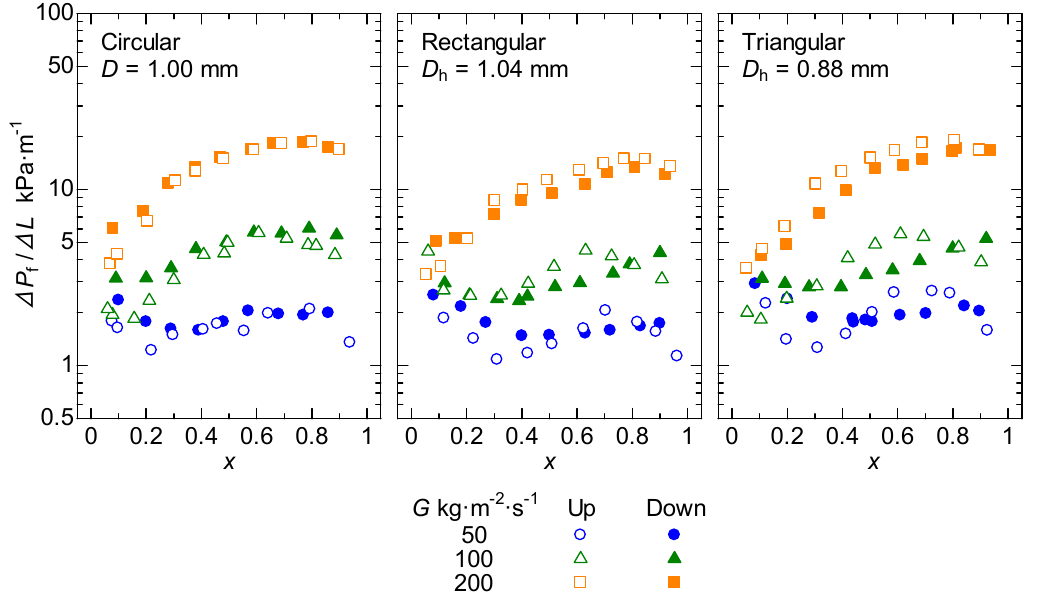
Figure 16. Comparison of the measured frictional pressure drop between upward and downward flow in circular, rectangular, and triangular tubes.